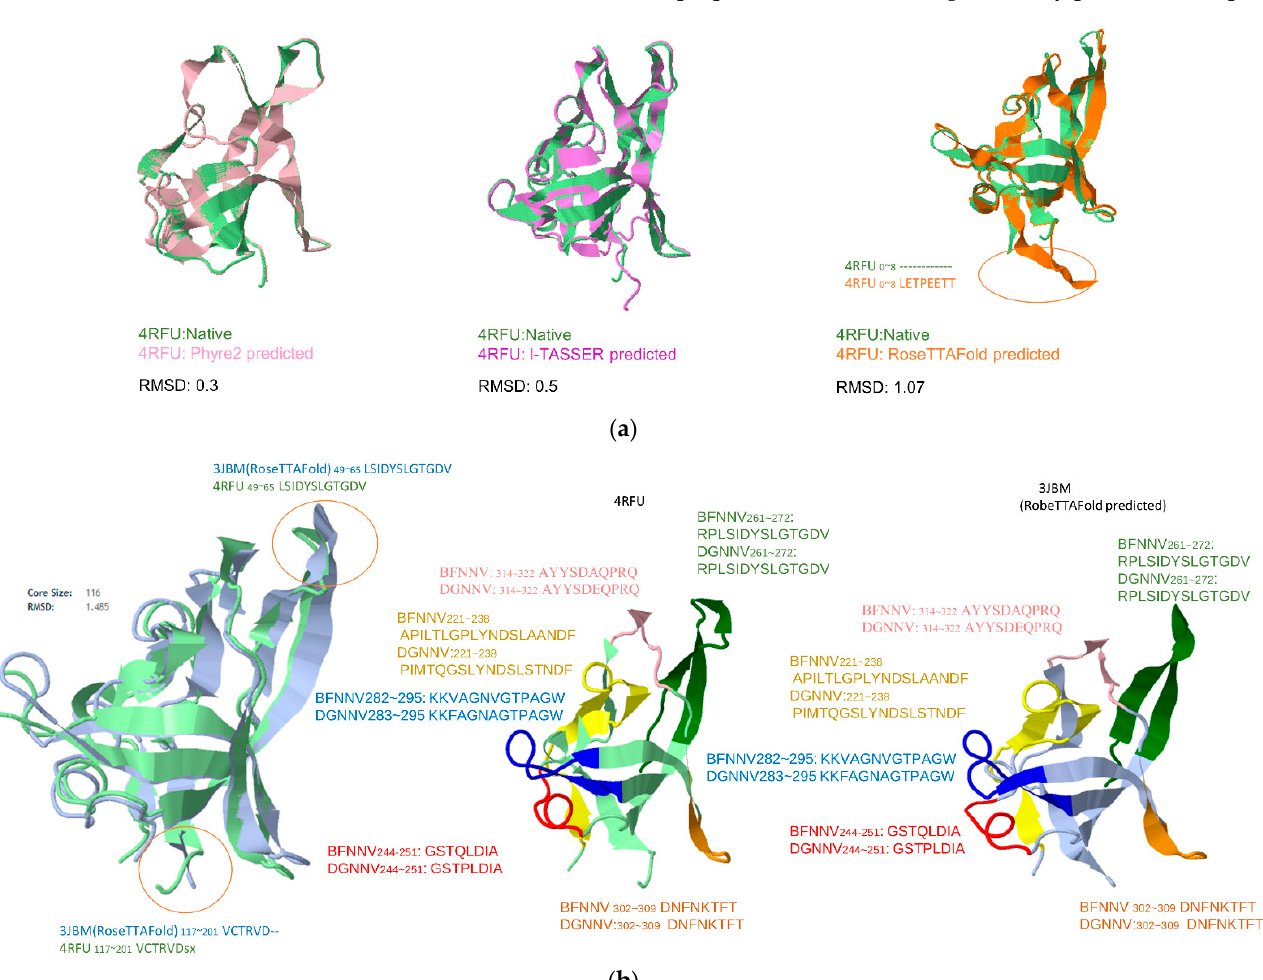
Figure 3. Structural alignment of predicted structures: ( a ) the resolved structure of RSCB PDB: 4RFU was aligned with 3 predicted structures by Phyre2, I-TASSER, and RoseTTAFold, respectively; ( b ) structural alignment and predicted epitopes of resolved 4RFU and the predicted 3JBM model by RoseTTAFold. Marked circles represent segments with major difference between predicted and resolved structures.